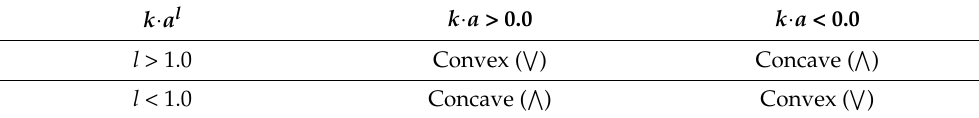
Table 2. Effects of the linearity parameter l .